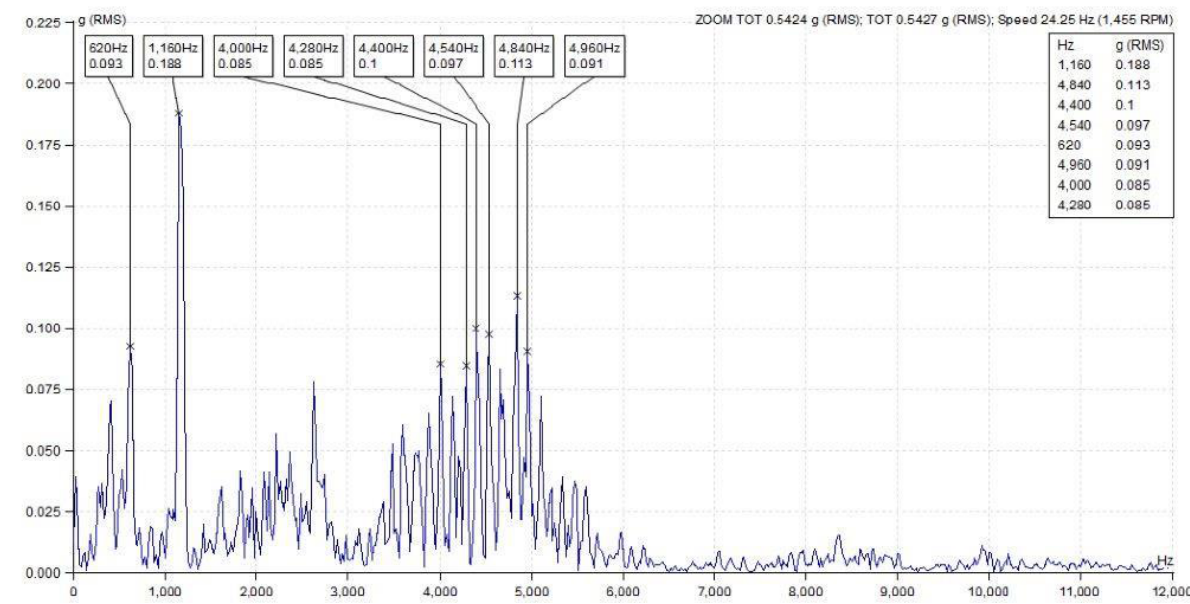
Figure 13. Bearing vibration spectrum in the range of 0 – 12,000 Hz.